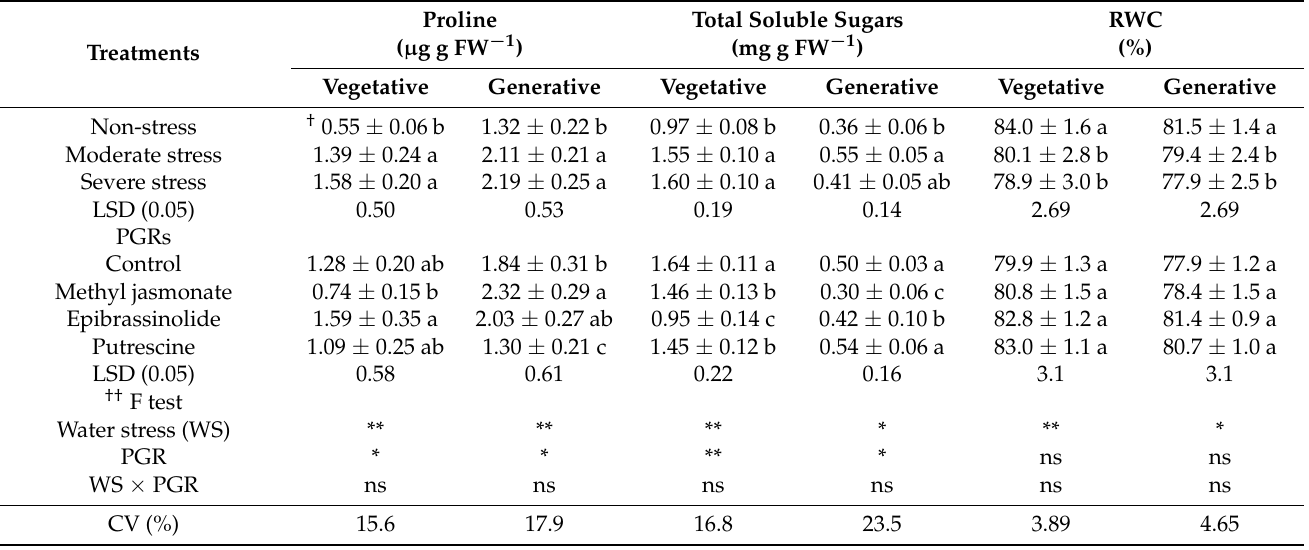
Table 1. Influence of water stress and PGR applications on osmotic adjustment and RWC of fennel ( Foeniculum vulgare Mill.) at two stages of